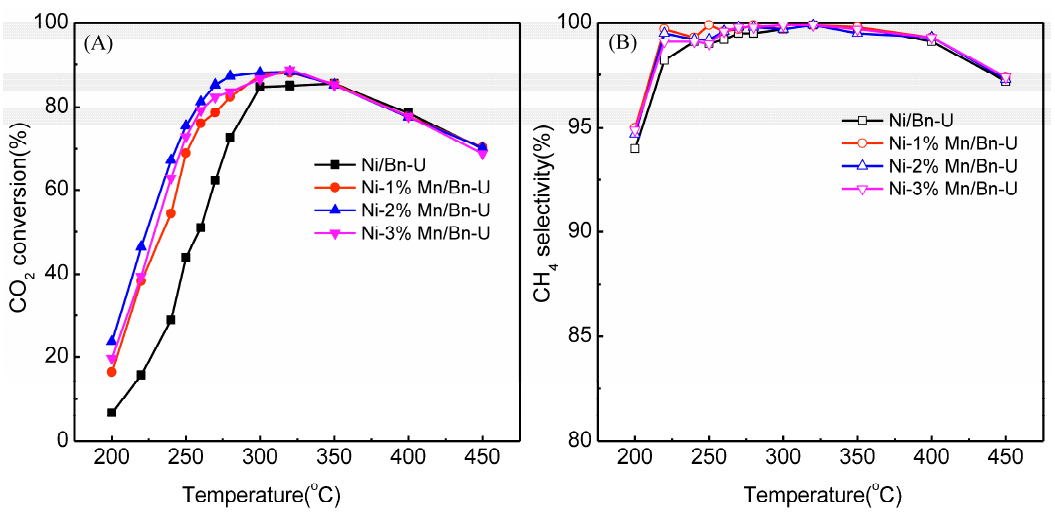
Figure 2. Effects of Ni/bentonite-U catalyst with different Mn amounts on the CO 2 conversion ( A ) and CH 4 selectivity ( B ). Reaction conditions: atmospheric pressure, V (H 2 )/ V (CO 2 ) = 4, GHSV = 3600 mL·g cat − 1 ·h − 1.